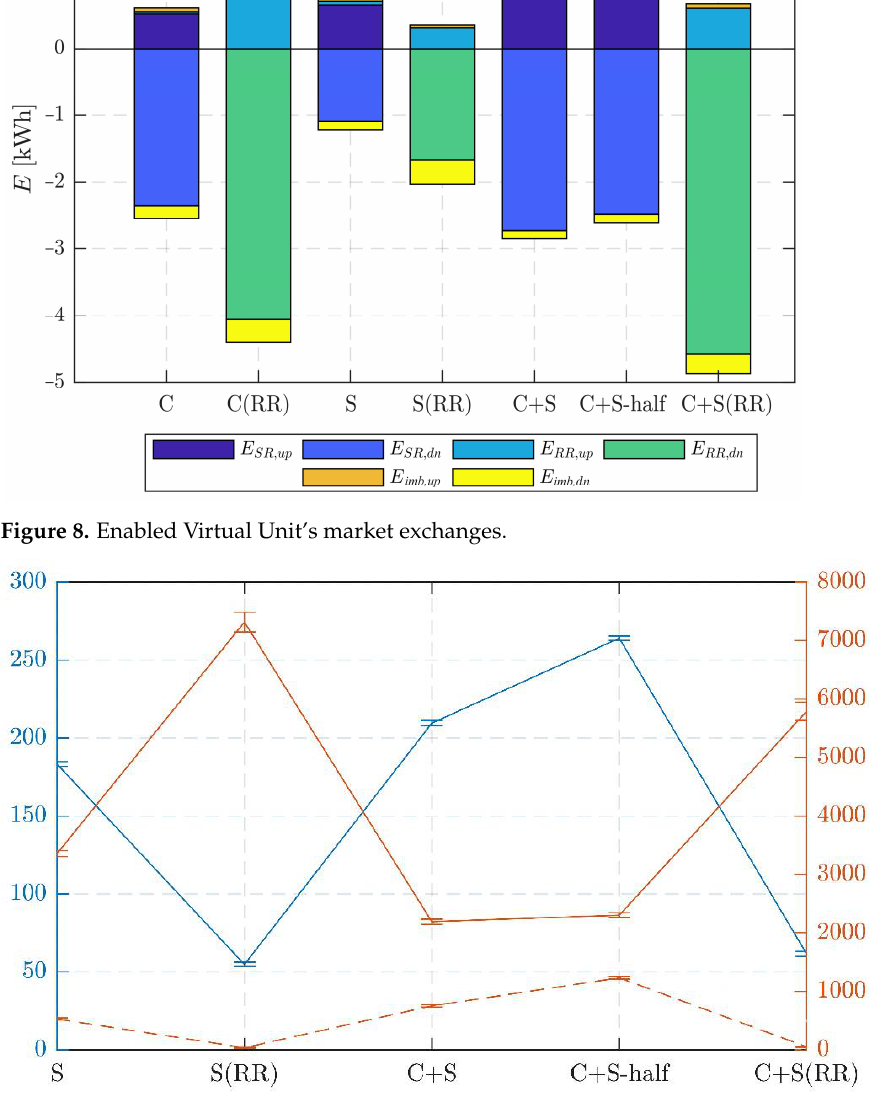
), axis on the left, and hours/year (cid:3030)(cid:3052)(cid:3030)(cid:3039)(cid:3032)(cid:3046)